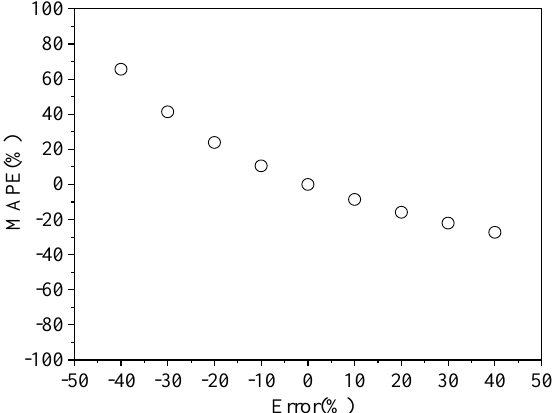
Figure 9. Variation of mean absolute square percentage error (MAPE) for Z SD , derived from the errors introduced by atmospheric correction.